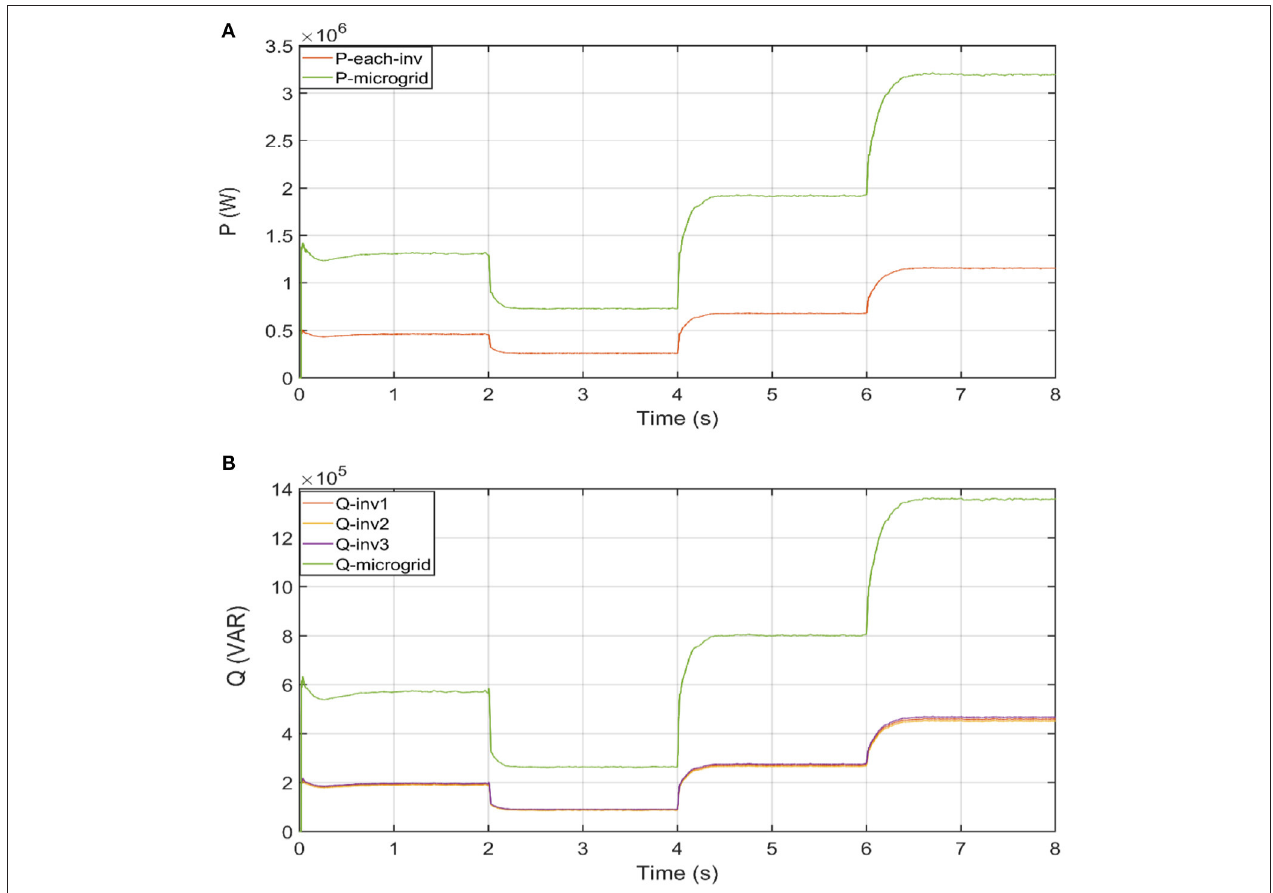
FIGURE 7 | Power sharing among three inverters. (A) Active power sharing. (B) Reactive power sharing.